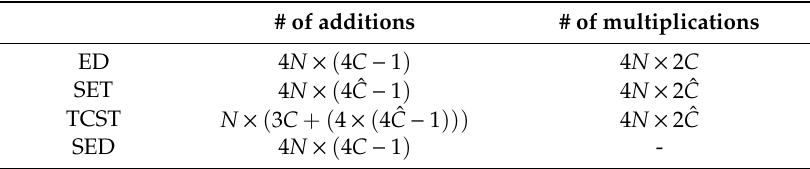
Table 3. Number of additions and multiplications of demodulation